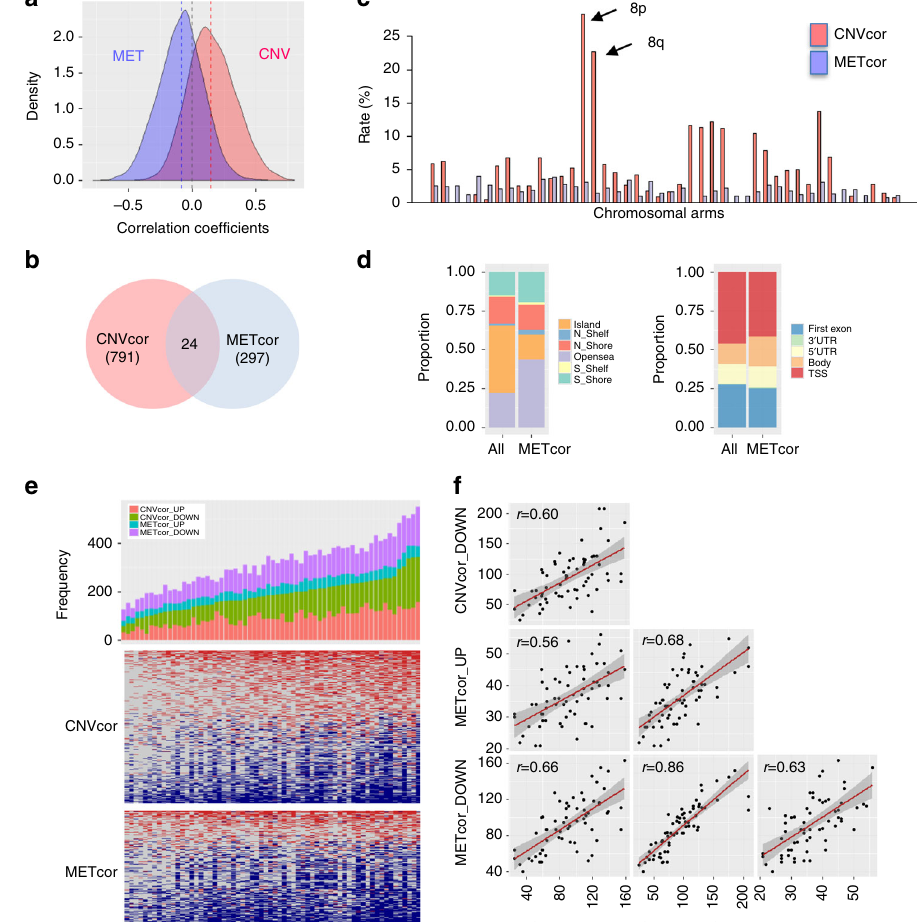
Fig. 1 Identi fi cation of DNA copy-number-correlated (CNVcor) and DNA methylation-correlated (METcor) genes in HCC. a Distribution of the correlation coef fi cients between the mRNA expression levels and DNA copy numbers or DNA methylation across the samples are shown, respectively. b A Venn diagram shows the counts of CNVcor and METcor genes. The counts of overlapped genes between CNVcor and METcor are indicated. c Proportional frequencies of the CNVcor or METcor genes against total gene counts in each chromosome arm are shown, respectively. d Genomic positions of DNA methylation probes are categorized based on the positional relations with CpG islands (right) and genes (left), respectively. The proportional frequencies in each category of DNA methylation for the whole genes and METcor genes are compared, respectively. e A barplot shows the frequencies of up- or down-expressed CNVcor genes or METcor genes in each sample (top). Each of CNVcor and METcor genes is categorized as upregulated (CNVcor_UP and METcor_UP) or downregulated (CNVcor_DOWN and METcor_DOWN) genes, respectively. Heatmaps show the up- (red) and down-expressed (blue) CNVcor (middle) and METcor (bottom) genes, respectively. f Dot plots show the pairwise correlations among the frequencies